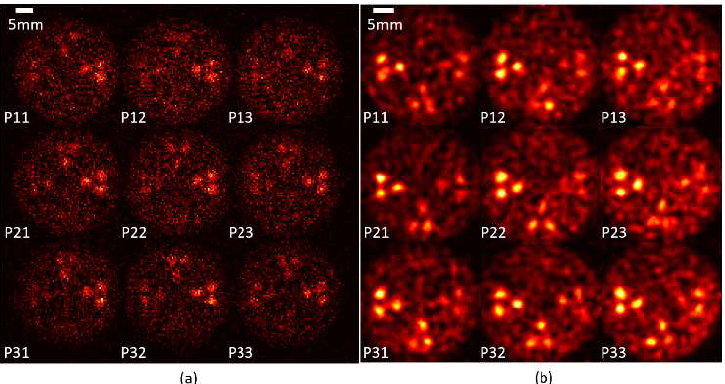
Figure 7. ( a ) Projection and ( b ) reconstructed images for single pinholes of PMP geometry.